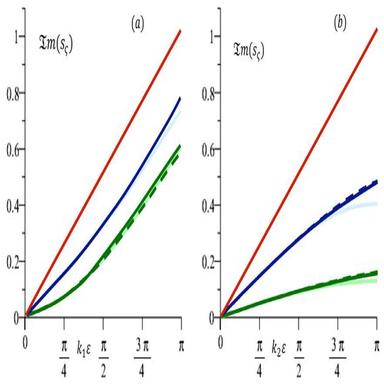
(a) Shear waves travelling along the layering direction e1 and (b) shear waves travelling along the direction e2, deriving from the homogenized model 1 (continuous dark line) and homogenized model 2 (dotted dark line) and from the heterogeneous one (light line), according to different values of the ratio between the mass densities and ratio between the Young's moduli: rρ = rE = 1 (red), rρ = rE = 10 (blue) and rρ = rE = 100 (green), by setting the dimensionless relaxation time as τ i ς = ∞ with ν˜1 = ν˜2 =